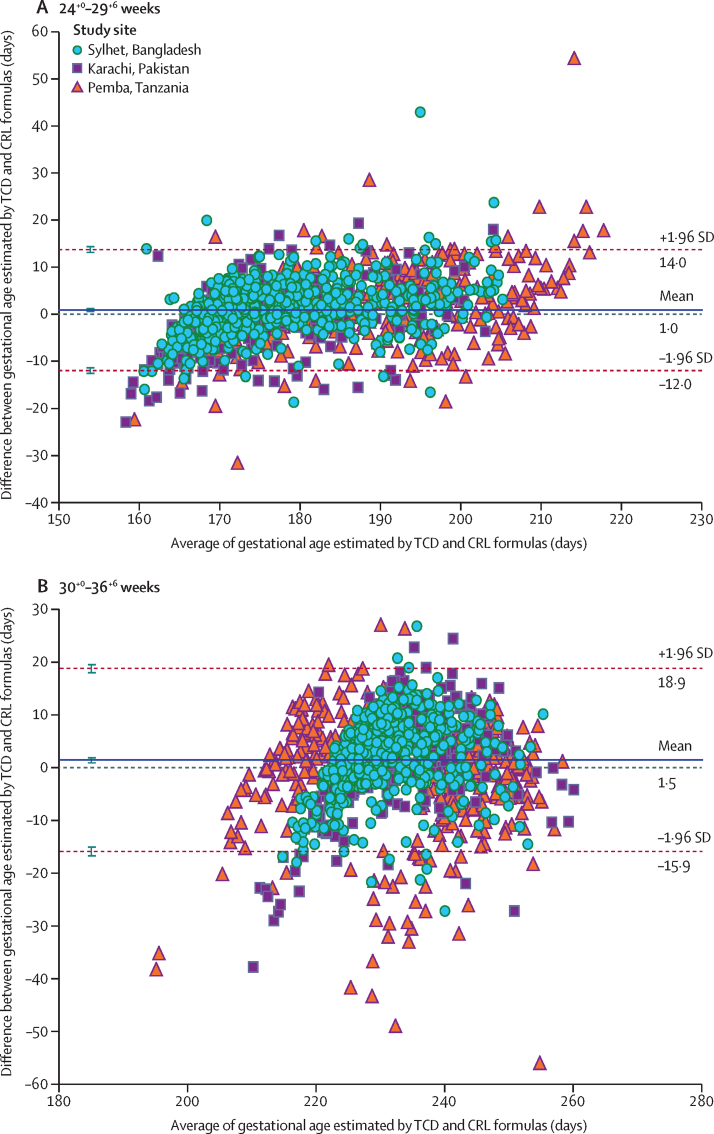
Bland-Altman plots comparing agreement of gestational age (days) determied by TCD measurements with first trimester CRL measurements at 24+0–29+6 weeks' gestation (A) and 30+0–36+6 weeks' gestation (B), by study siteThe identity line at y=0 represents values for which the TCD and CRL measurements would yield the same unbiased estimate of gestational age. The mean difference (ie, bias) is the average difference between the two measurements and is plotted as a solid line. The 95% limits of agreement between the two methods are represented by the dashed lines. TCD=transcerebral diameter. CRL=crown-rump length.